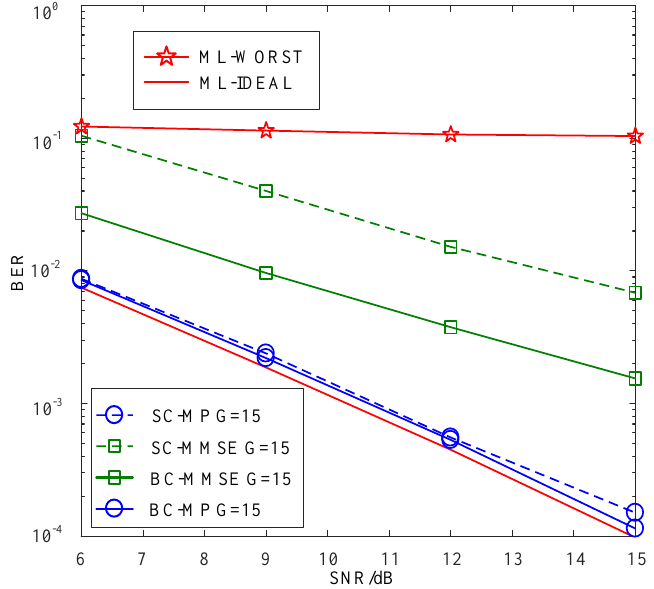
Figure 11. BER comparisons of the proposed SC-MMSE, SC-MP, BC-MMSE, and BC-MP detectors for the GSTFIM systems with G = 15, N t = 2, and N r = 4 in three